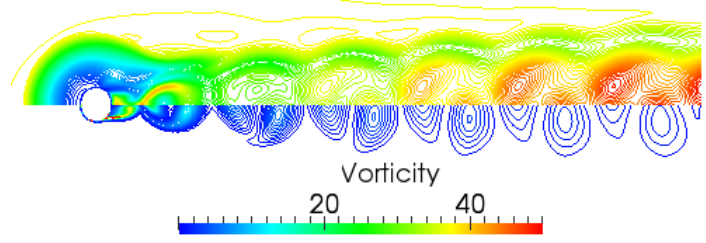
Figure 2. Instantaneous spatial distribution of the fully developed turbulent viscosity and vorticity around the cylinder at Re = 10 6 [23].